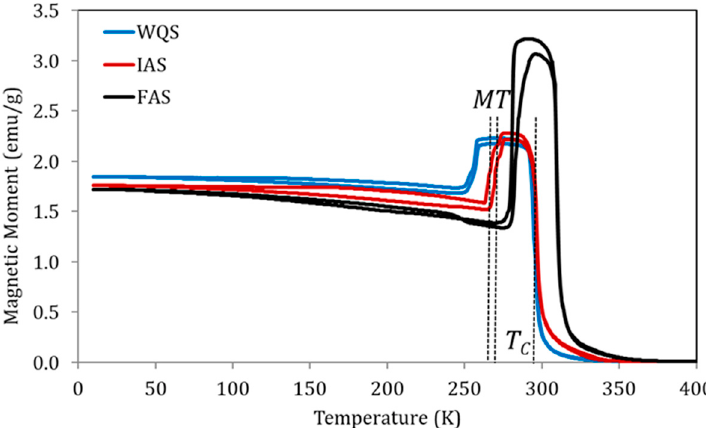
Figure 4. Magnetization vs temperature curves under a constant magnetic field of 5 mT for samples of alloy Cu5 quenched from 1020 K in three different post-quench ageing states: just quenched (WQS), intermediate-aged (IAS), and full-aged (FAS).